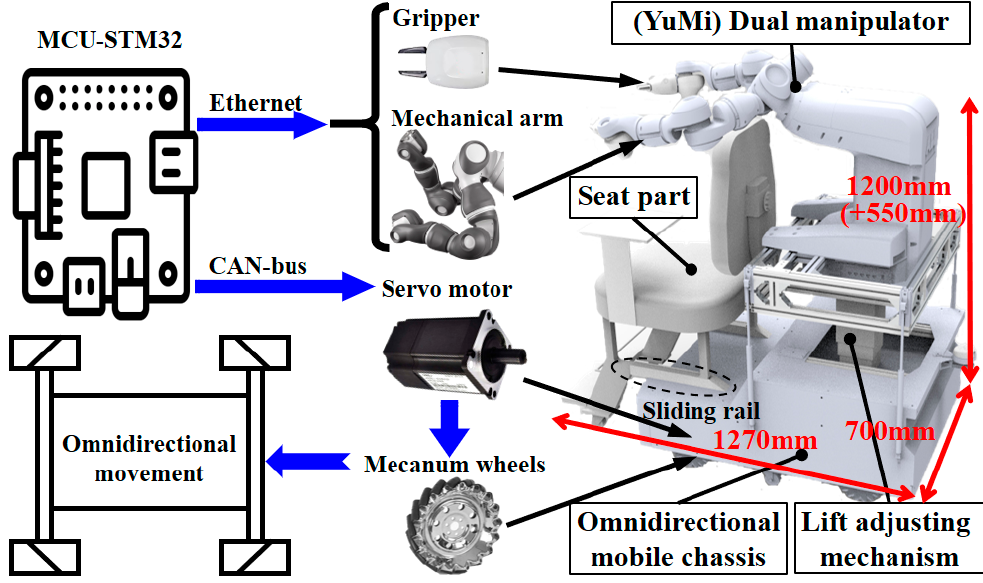
Figure 3. Concept design of the nursing-care assistant robot consisting of an omnidirectional mobile chassis, lift adjusting mechanism, dual manipulator, and the seat part. The communication protocol of the robot control system is shown as well.